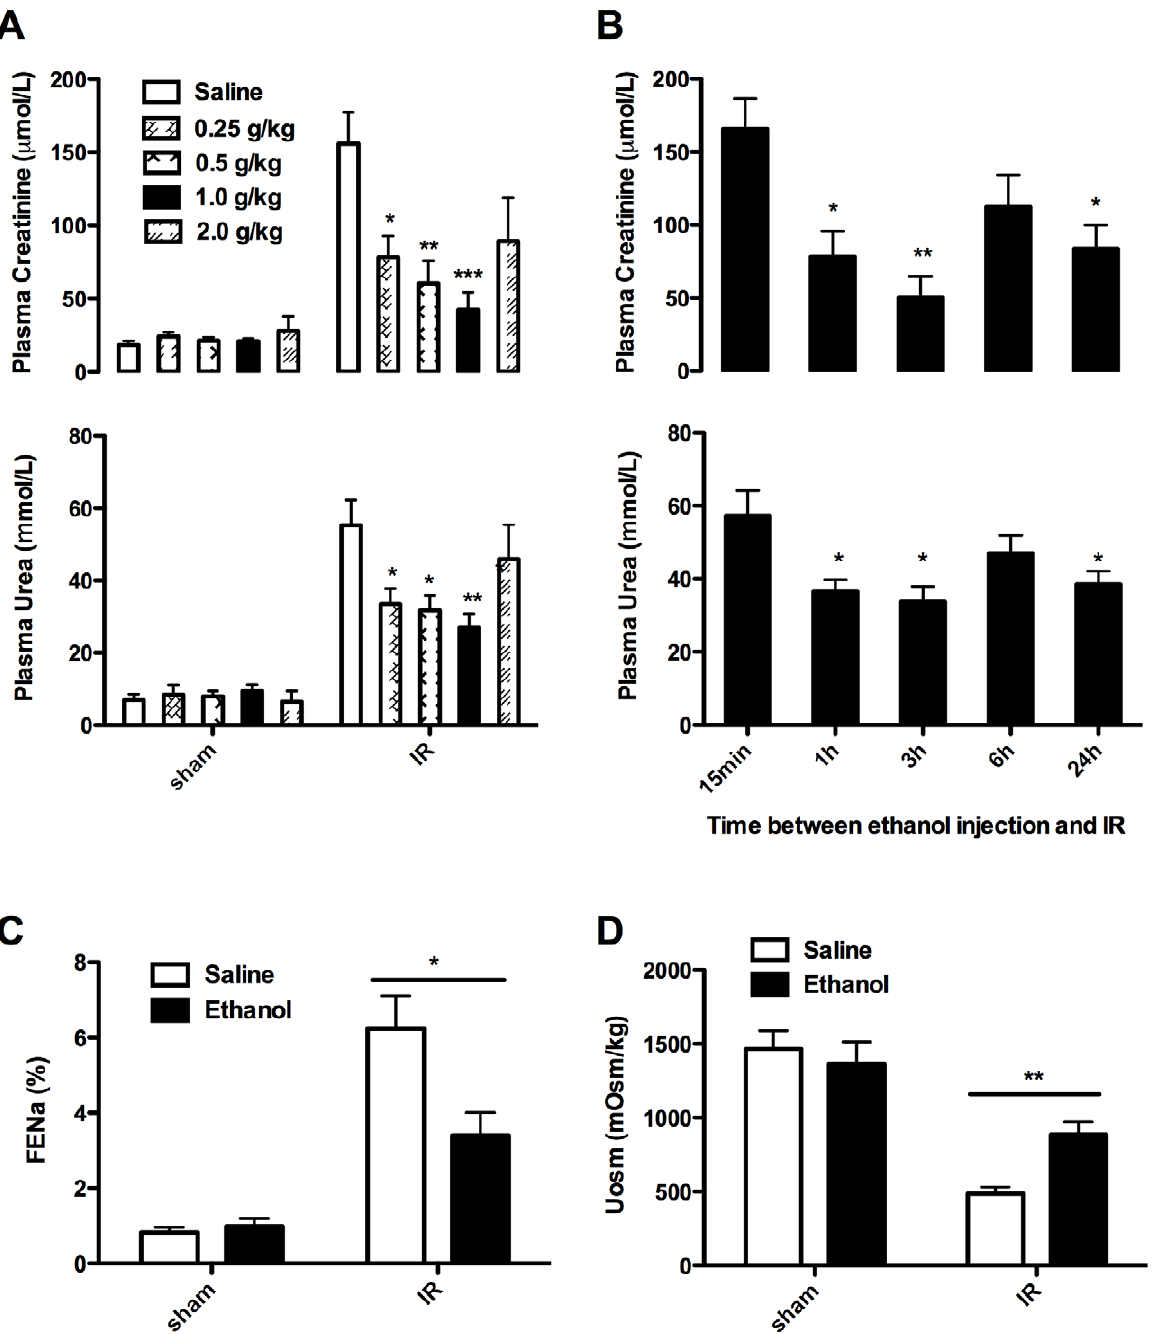
Figure 2. Ethanol pretreatment preserved kidney function after renal IR. A. Mice were pretreated with saline or ethanol at different dose. A 30 min bilateral renal ischemia was induced 3 h later. Blood samples were harvested at 24 h after reperfusion to assess the plasma creatinine and urea. Sham controls underwent the same procedure without vascular occlusion. Results are mean values 6 SEM ( n =4–8). B. Mice were pretreated with ethanol (1 g/kg) and exposed to a 30 min bilateral renal ischemia after different time interval. Blood samples were harvested at 24 h after reperfusion to assess the plasma creatinine and urea. Results are mean values 6 SEM ( n =5–6). C. & D. Mice were pretreated with saline or 1 g/kg ethanol, and were exposed to a 30-min bilateral renal IR 3 h later. FE Na and Uosm were assessed at 24 h after reperfusion. (* p , 0.05, ** p , 0.01, *** p , 0.001, in comparison with saline control of that group (sham or IR) for A. , and with the 15 min group for B. ).